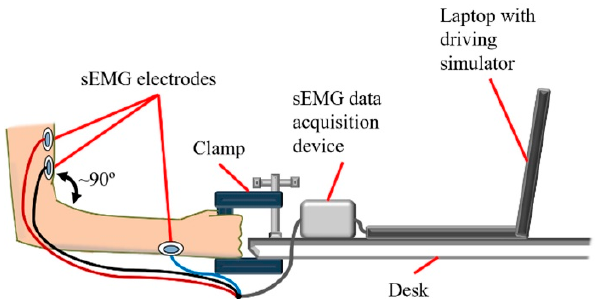
Figure 5. Steering assistance interface adapted to driving simulator.